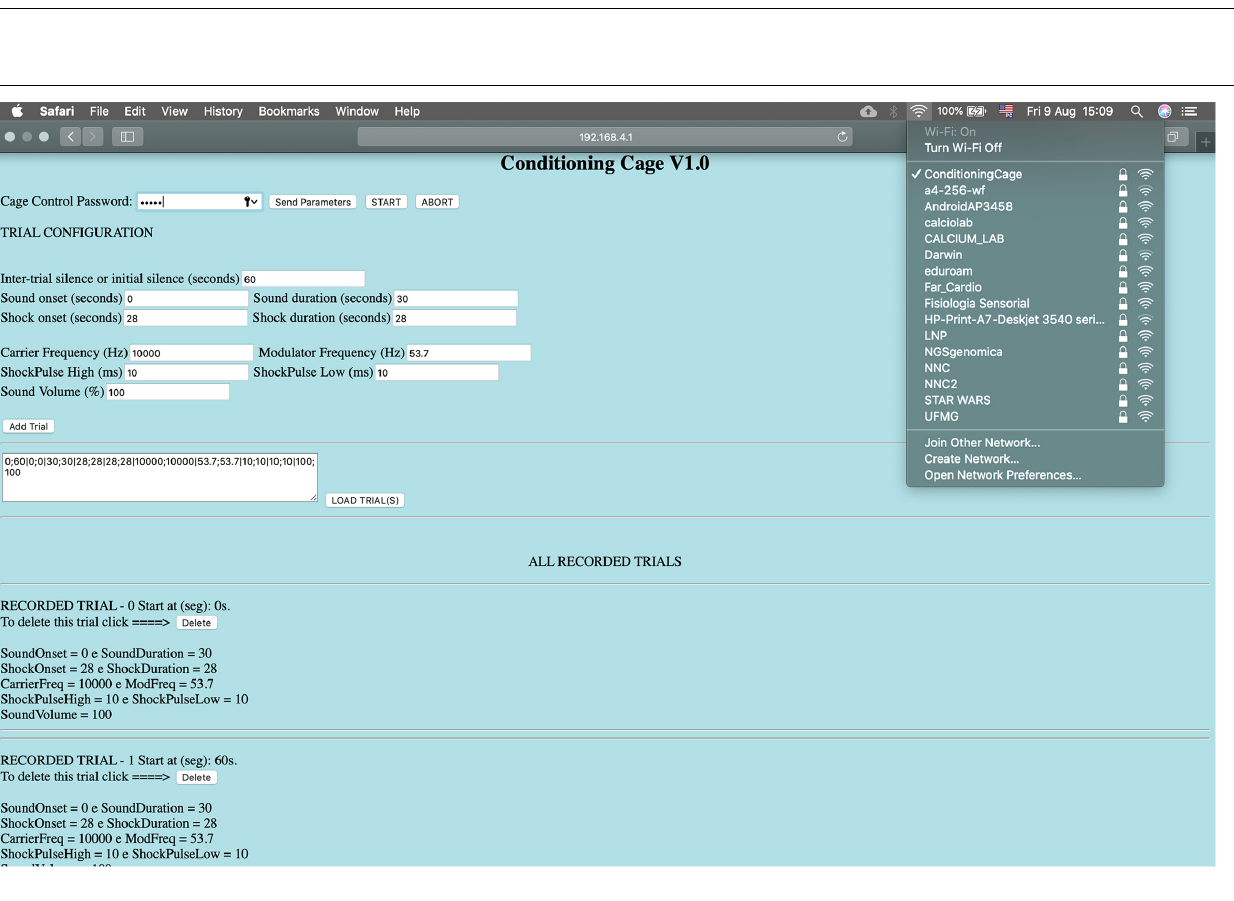
FIGURE 2 | The conditioning chamber can be remotely controlled by a HTML interface. Parameters: Sound and shock onset (seconds), pulse-shock interval (milliseconds to seconds), sound intensity (%), sound carrier frequency and modulating frequency. Each added trial can be saved and loaded. Wi-Fi connection: Conditioning Cage, IP address: http://192.168.4.1, Password: 0112358132, password to send the parameters: 12345. Start/Abort: Start and stop experiment.